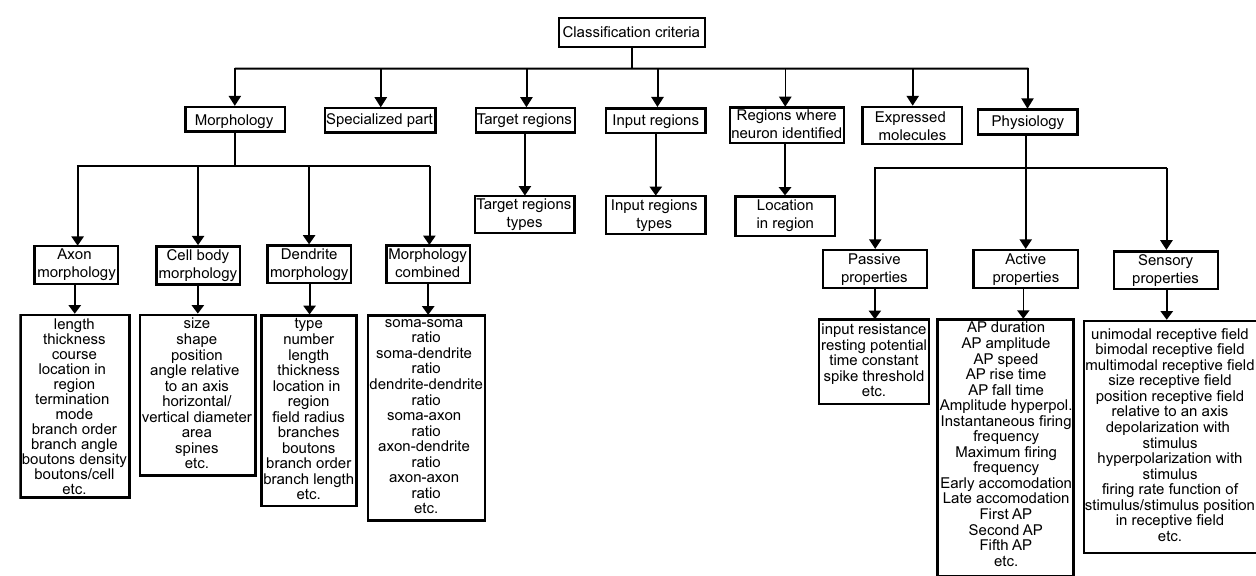
Figure 3. Schema of classifi cation criteria associated with “is-a” relations between neurons in BAMS Neuroanatomical Ontology